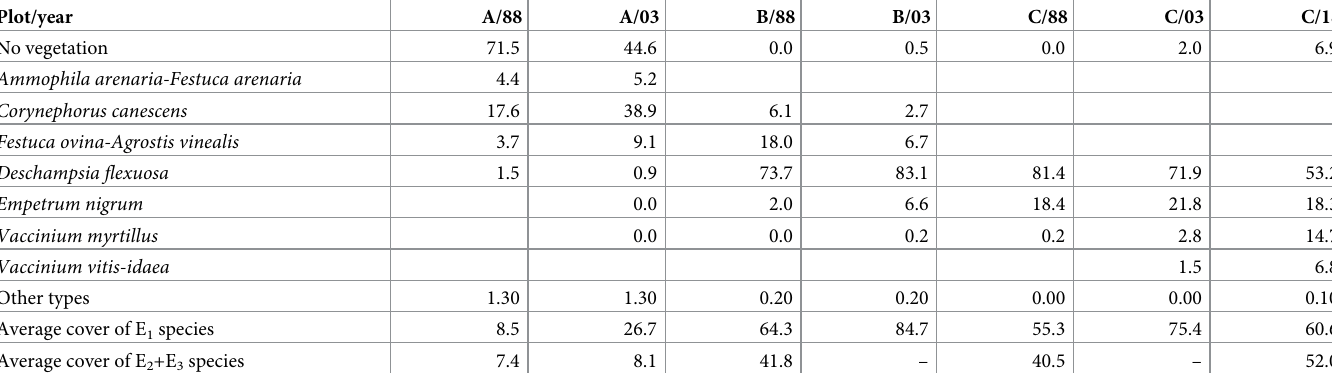
Table 1. Percentages of vegetation types (mapping units) in plots (A, B, C) in sampling years (1988, 2003, 2018). –missing data; 0.0 negligible